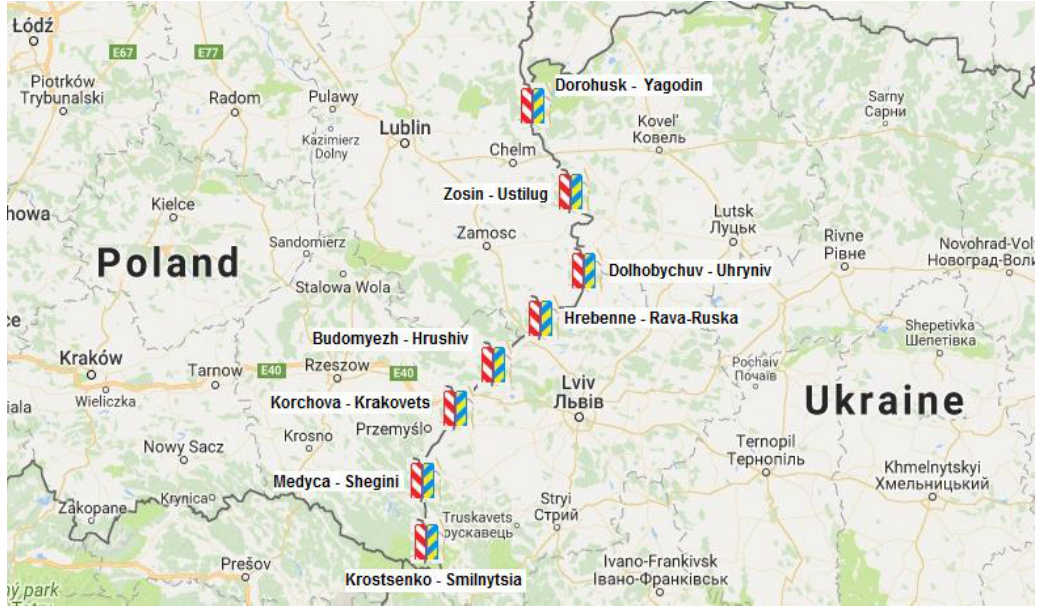
Figure 1: Automobile checkpoints at the Ukrainian-Polish